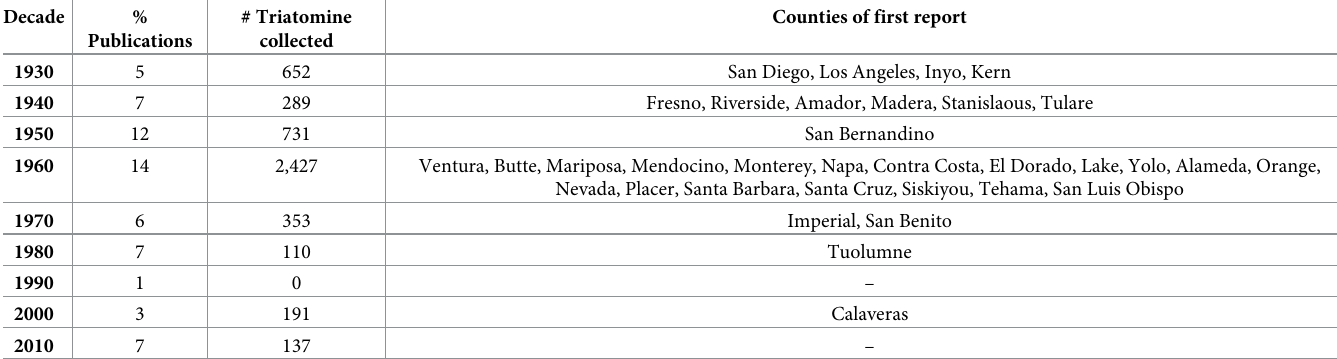
Table 1. Temporal distribution of publications, triatomines collected, and first county reports of autochthonous Trypanosoma cruzi